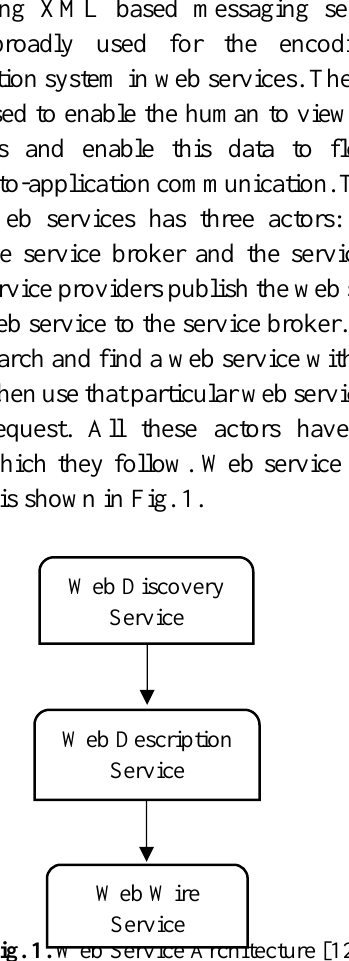
Fig. 1. Web Service Architecture